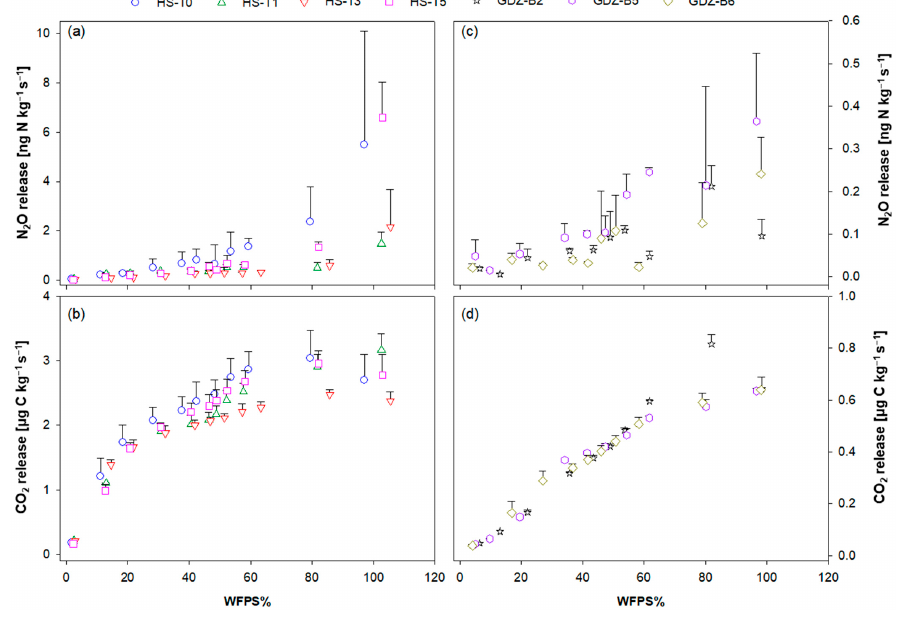
Figure 5. N 2 O-N and CO 2 -C release rates of ( a , b ) HS soils HS-T0, HS-T1, HS-T3, HS-T5 and ( c , d ) GDZ soils GDZ-B2, GDZ-B5 and GDZ-B6 as a function of WFPS in the dry-out experiment at 30 °C. Values are means and standard deviations. Note different scales of y-axes for ( a , b ) and ( c , d ).